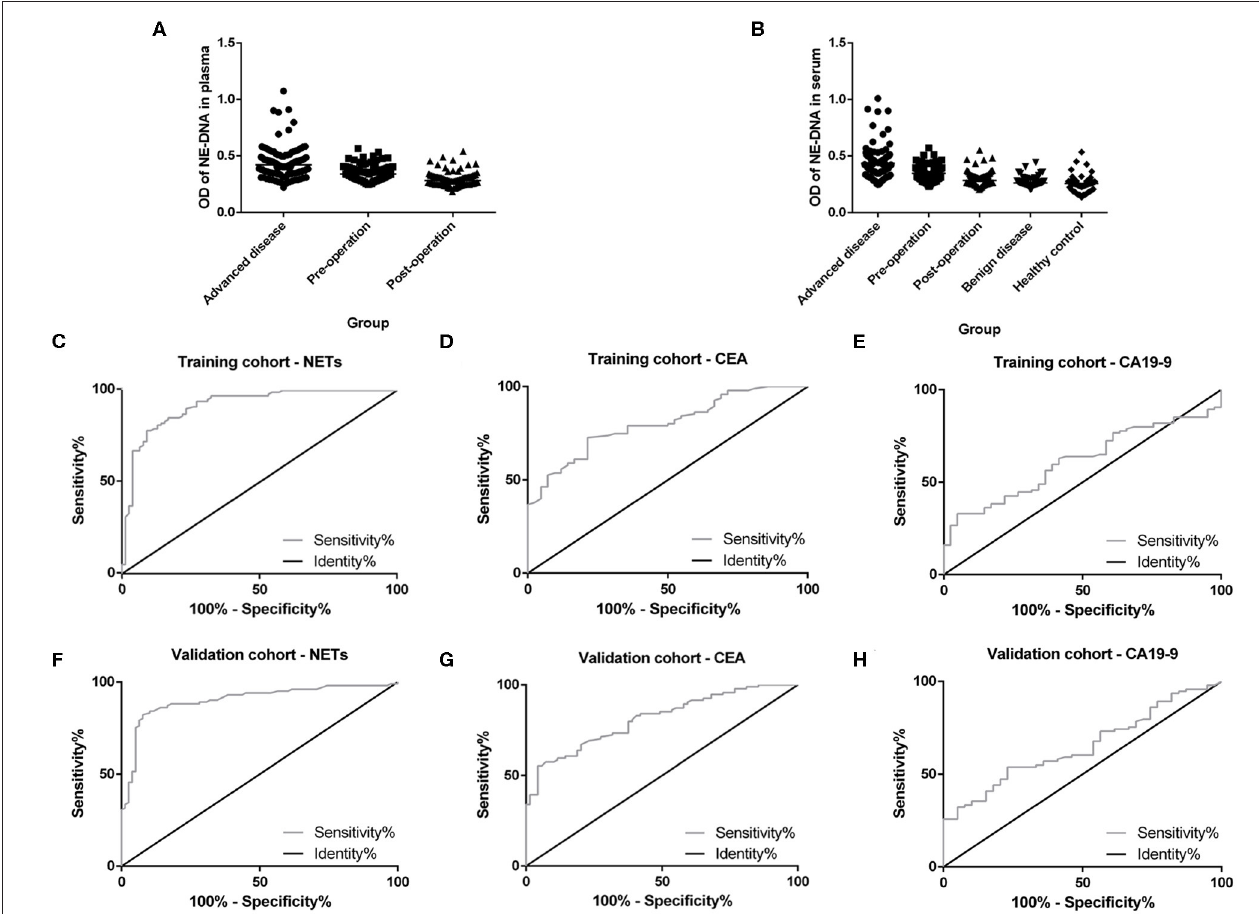
FIGURE 3 | Neutrophil extracellular traps (NETs) in the peripheral blood (PB) of participants and the diagnostic capacity in gastric cancer (GC). (A) Gradual decline in the levels of NETs in the plasma from advanced disease patients to postoperative patients. (B) Gradual decline in levels of NETs in the serum from advanced disease patients to controls. (C,F) Diagnostic capacity of NETs in the training cohort (AUC = 0.916; C ) and the validation cohort (AUC = 0.903; F ). (D,G) Diagnostic capacity of carcinoembryonic antigen (CEA) in the training cohort (AUC = 0.799; D ) and the validation cohort (AUC = 0.812; G ). (E,H) Diagnostic capacity of carbohydrate antigen 19-9 (CA19-9) in the training cohort (AUC = 0.614) and validation cohort (AUC = 0.650; H ).